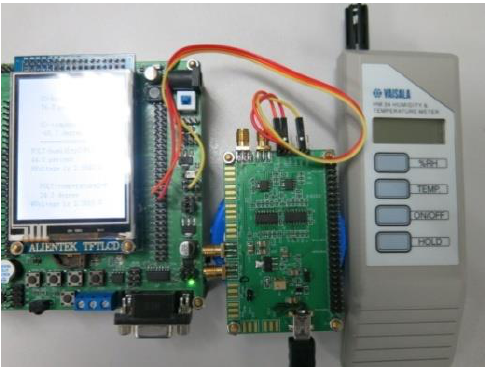
Figure 13. Prototype sensor with LCD display module ( Left ), PCB integration of sensor device and ASIC ( Middle ) and standard humidity sensor ( Right ).